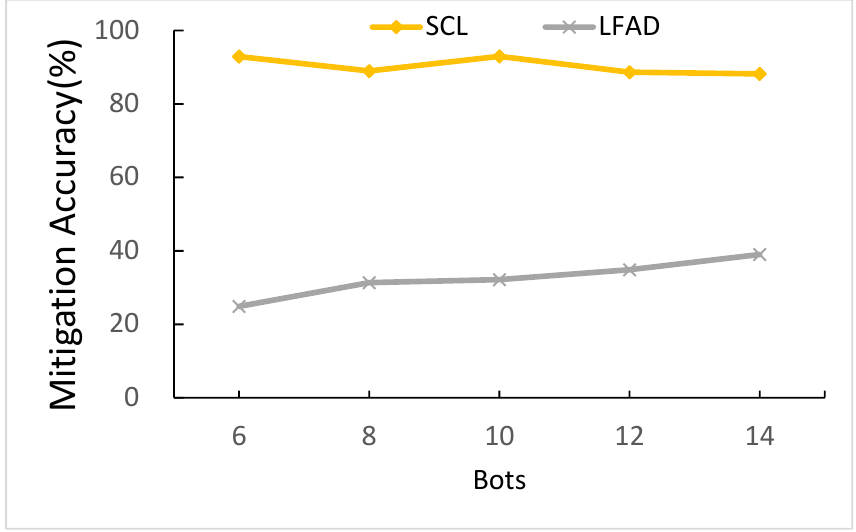
Figure 18. Comparison of the number of bots.